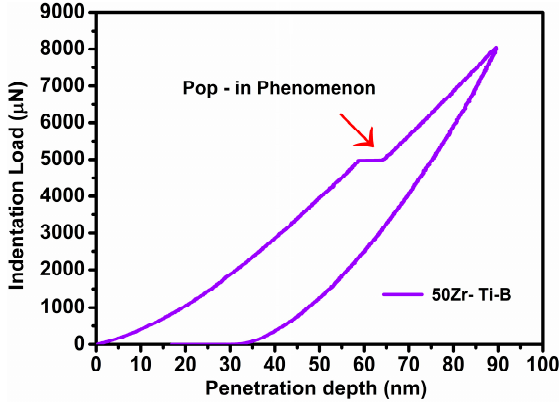
Figure 12. Load vs. displacement profile of 50Zr-50Ti-B sample.